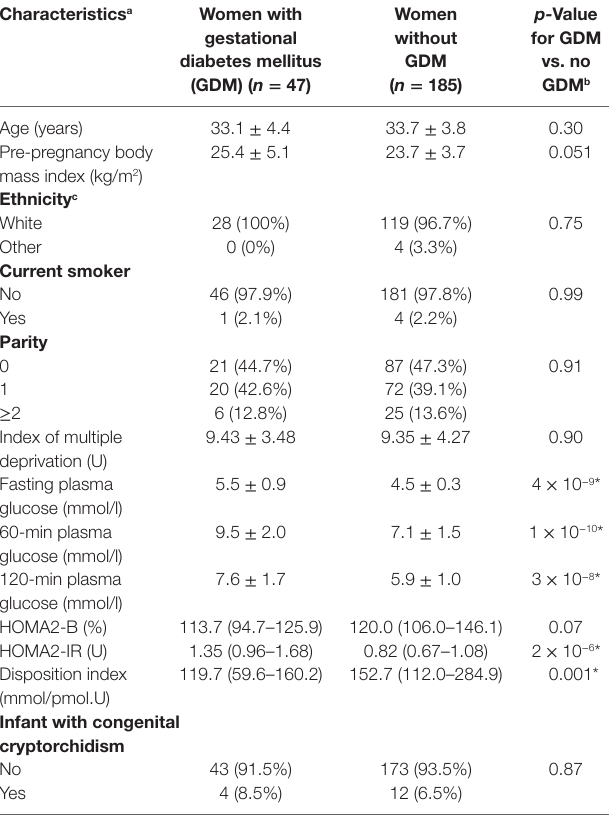
Table 3 | Adjusted odd ratios and 95% CIs for incident gestational diabetes mellitus in relation to log-transformed serum chemical concentrations.